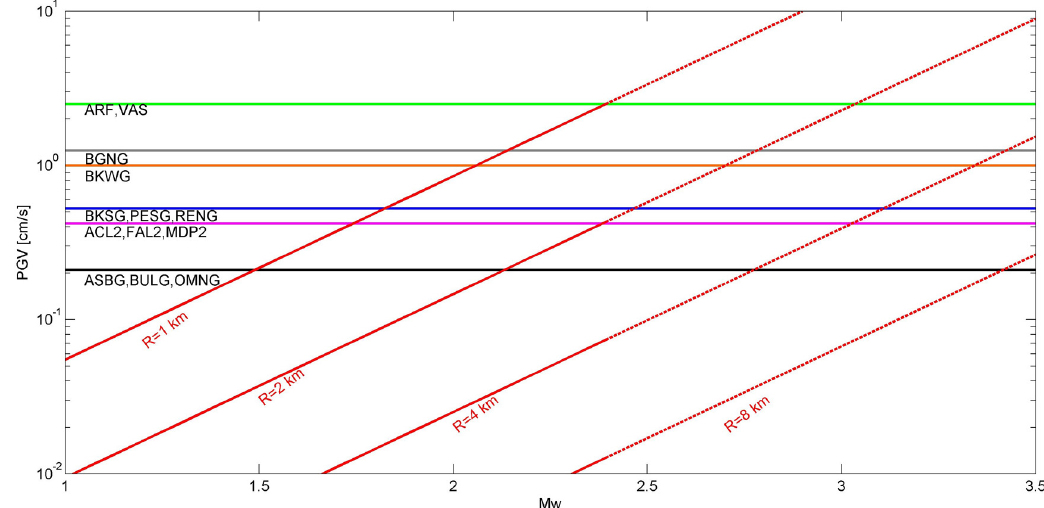
Figure 5. Maximum detectable amplitude of some stand-alone seismic stations currently installed in Campi Flegrei and Vesuvius (horizon- tal lines), and the theoretical amplitude versus magnitude computed for different hypocentral distances at Campi Flegrei (red lines). The con- tinuous part of red lines identify the magnitude ranges for which GMPEs can be considered reliable (M